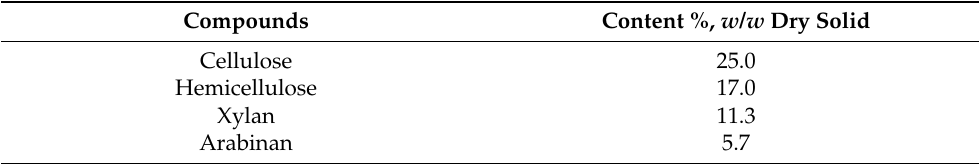
Table 2. The chemical composition of dried orange peel.